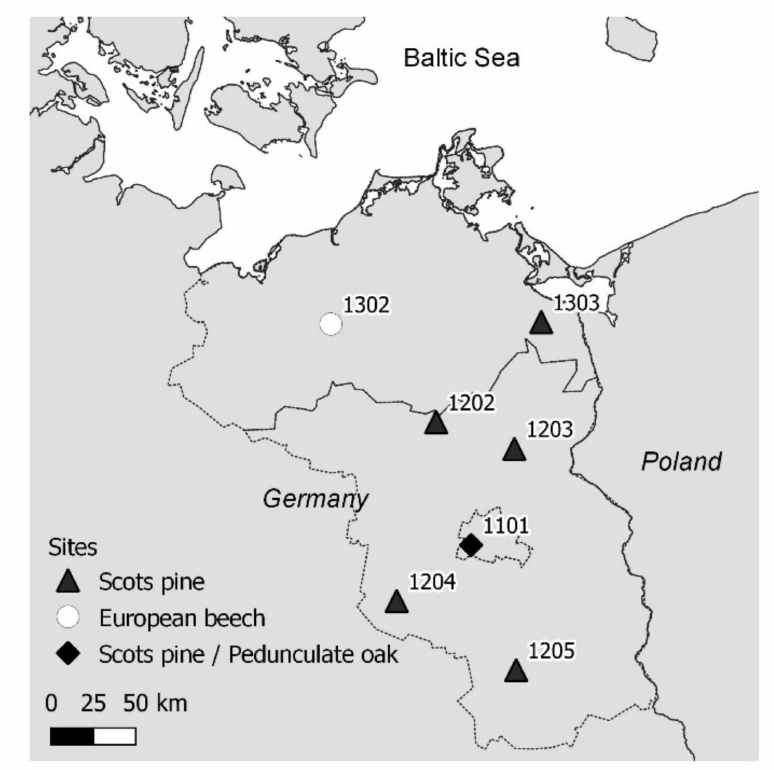
Figure 1. Location of the